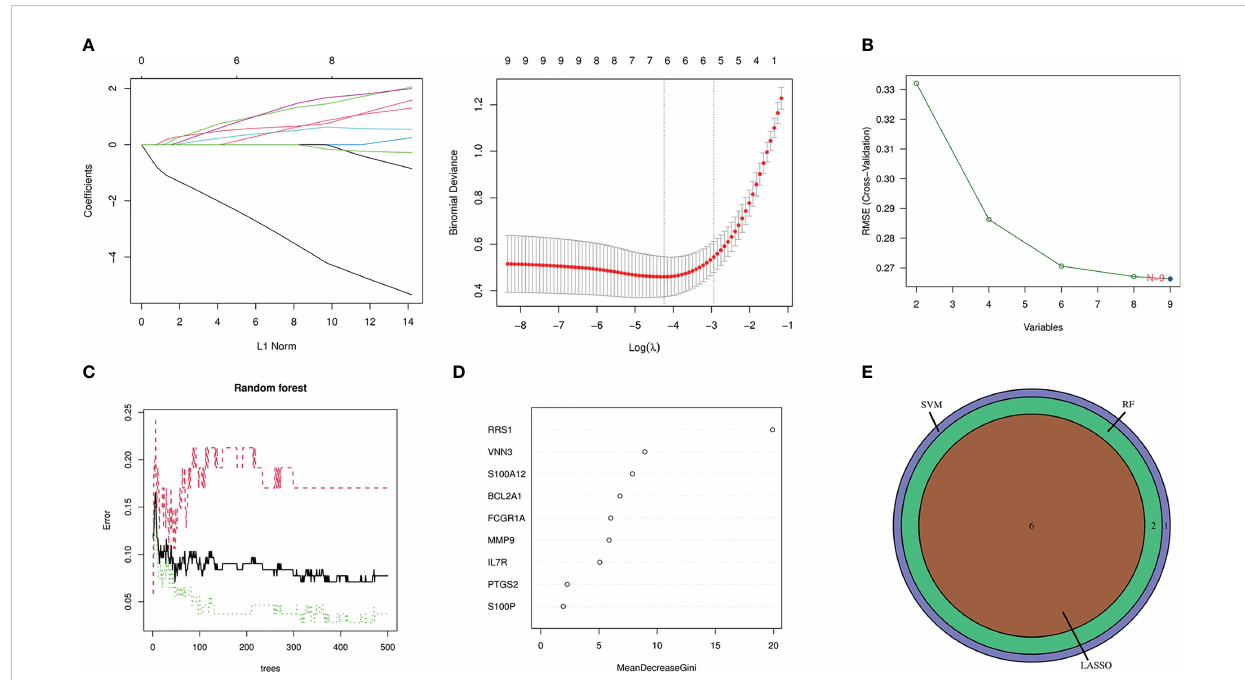
FIGURE 7 Machine-learning algorithm screening for candidate biomarkers of NAFLD with IS. (A) Biomarker screening in the Lasso regression. The lowest point of the curve corresponds to the optimal number of genes (n = 6). (B) SVM-RFE algorithm screening for biomarkers. (C) The relationship between the number of trees and the error rate is displayed in a random forest. (D) Ranking of genes according to their relative importance. (E) Venn diagram depicting 6 candidate genes screened by 3 machine-learning